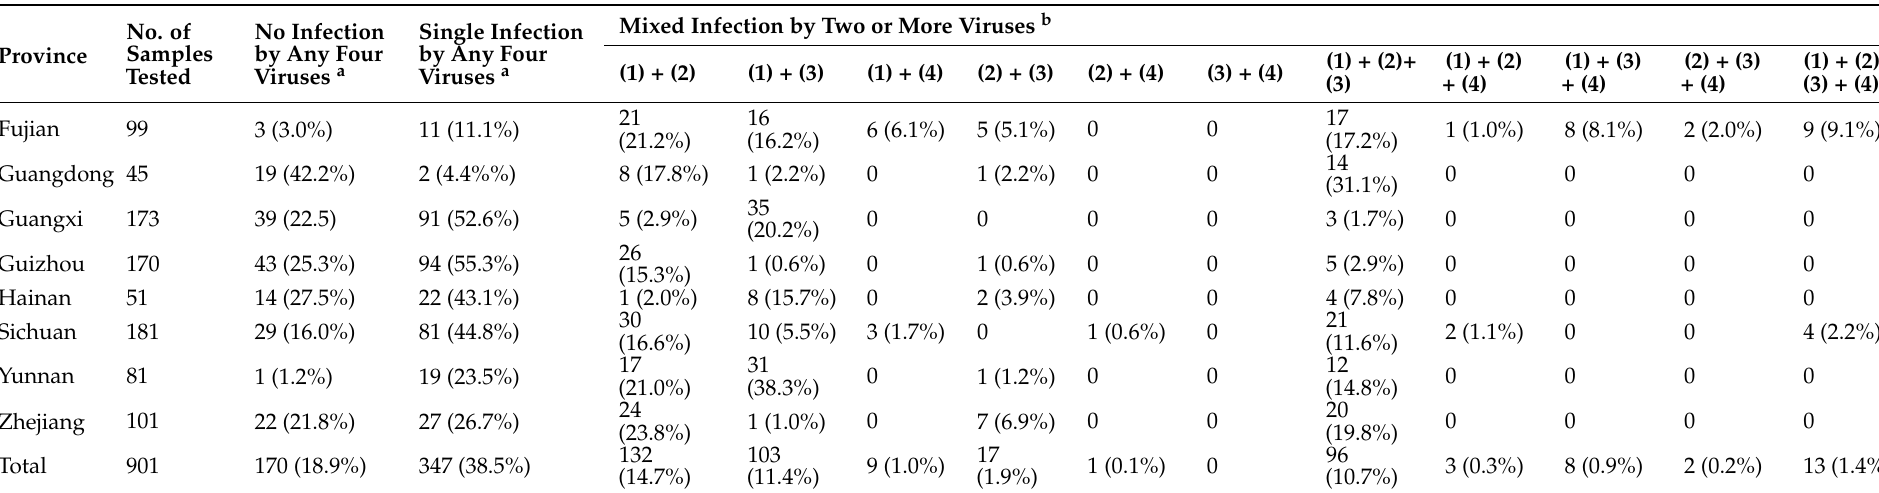
Table 2. Percentage (%) of mixed infections by SrMV, SCMV, SCSMV, and MaYMV in sugarcane in eight provinces in